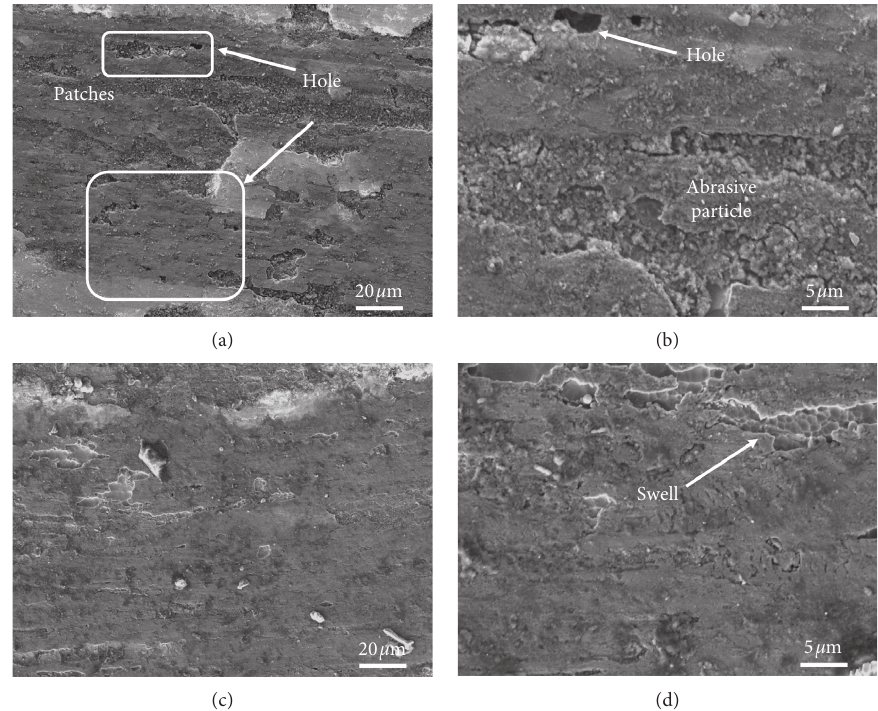
Figure 13: SEM images of the worn surfaces of Inconel 625 after grinding with Si enlarged views of (a) and (c), respectively.